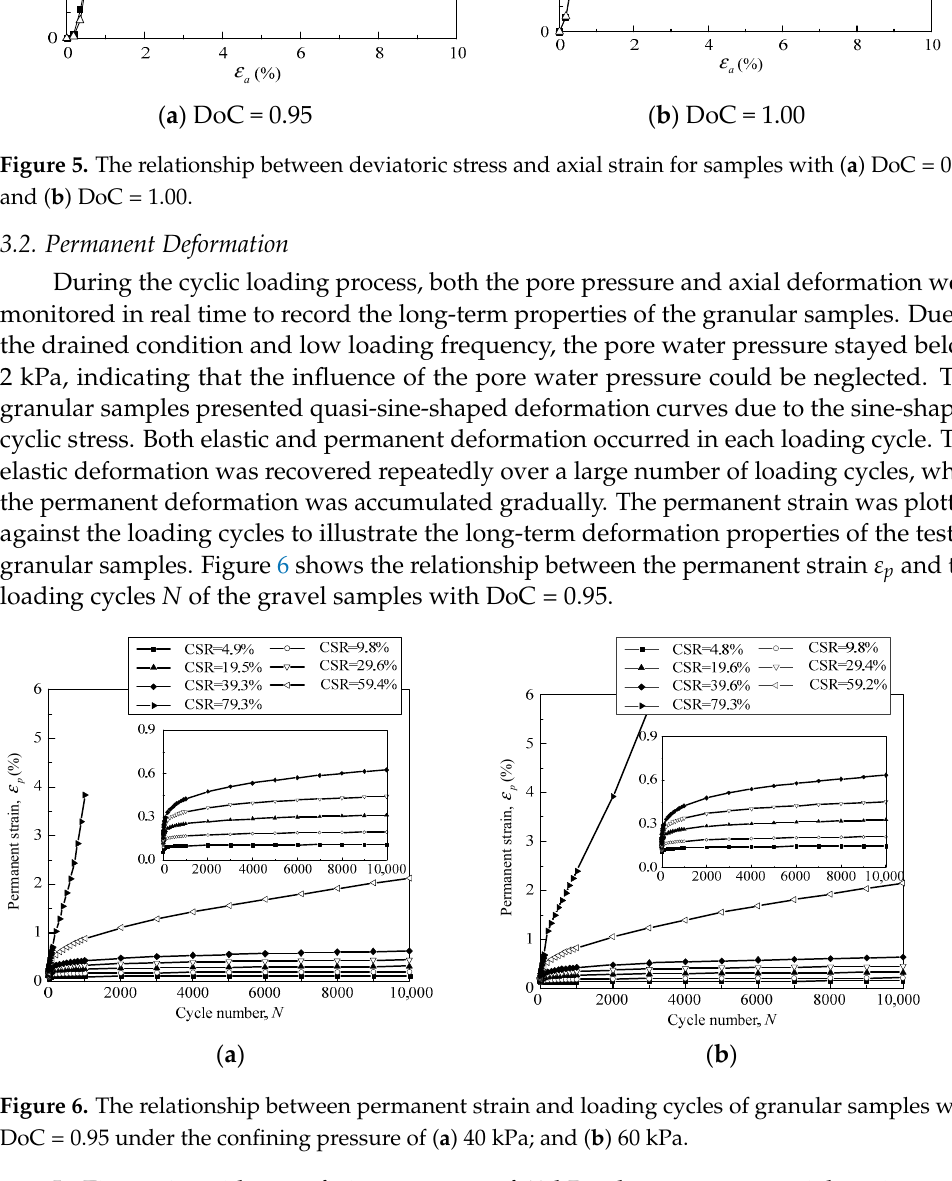
p ε ( a ) ( b ) Figure 7. The relationship between permanent strain and loading cycles of granular samples with DoC = 1.00 under the confining pressure of ( a ) 40 kPa; and ( b ) 60 kPa.